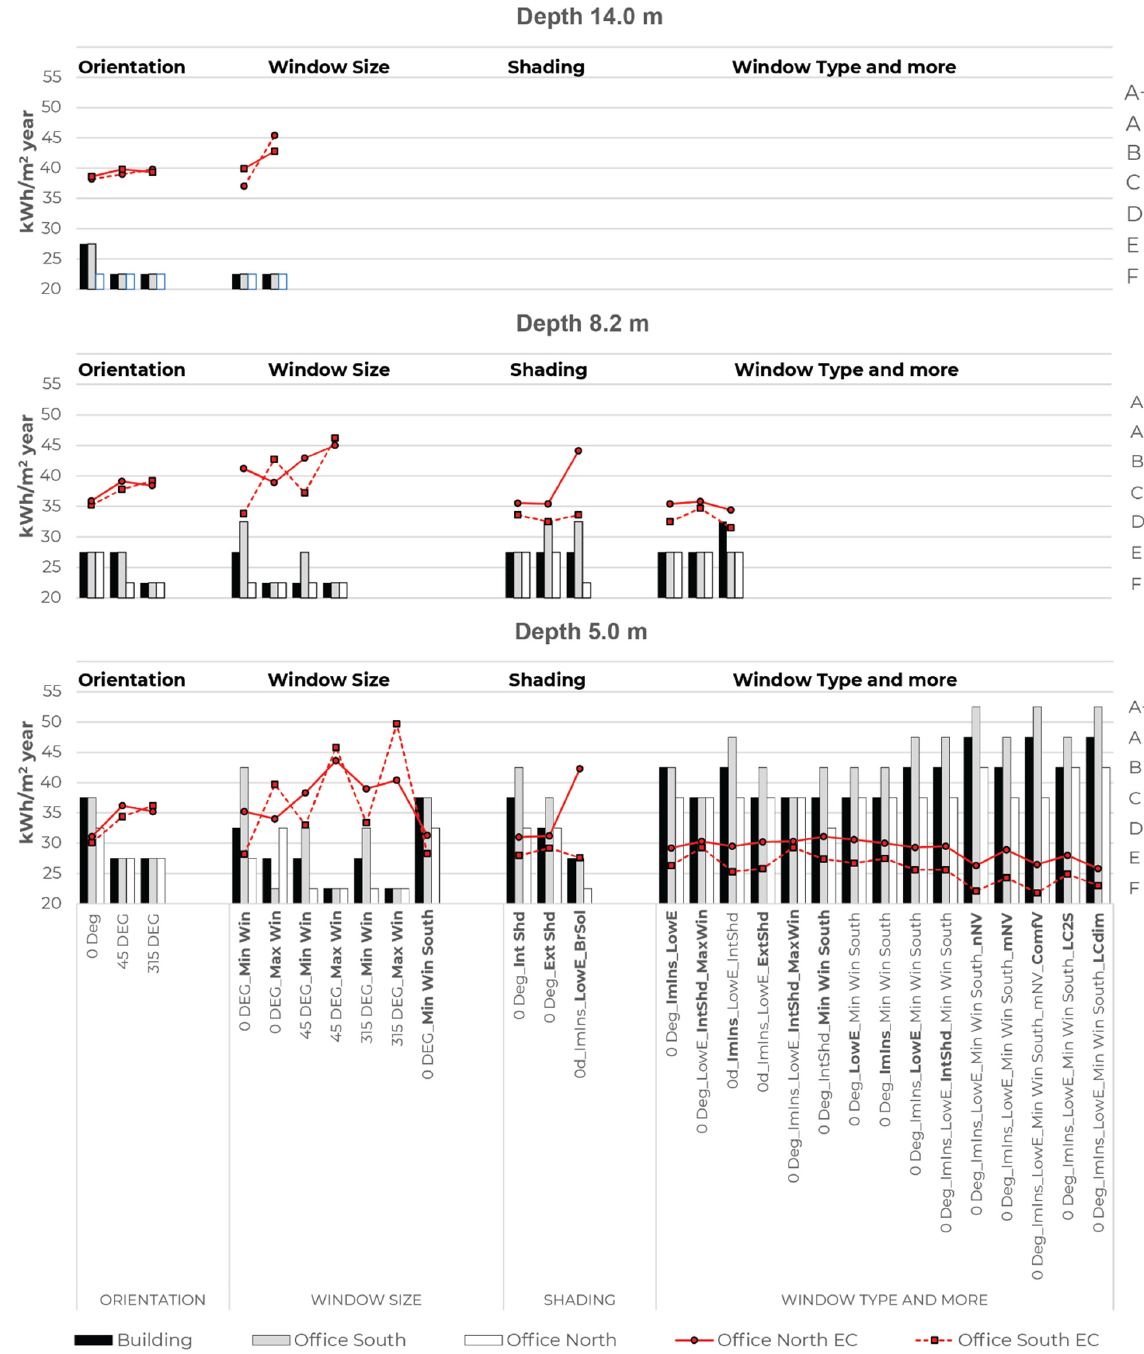
Figure 10. Case study building 2: Energy consumption and rating of design alternatives and decision making during the design process. Top: Deep offices (14 m); Middle: Standard depth (8.2 m); Bottom: Shallow depth (5 m). In bold: parameter changed in each alternative.